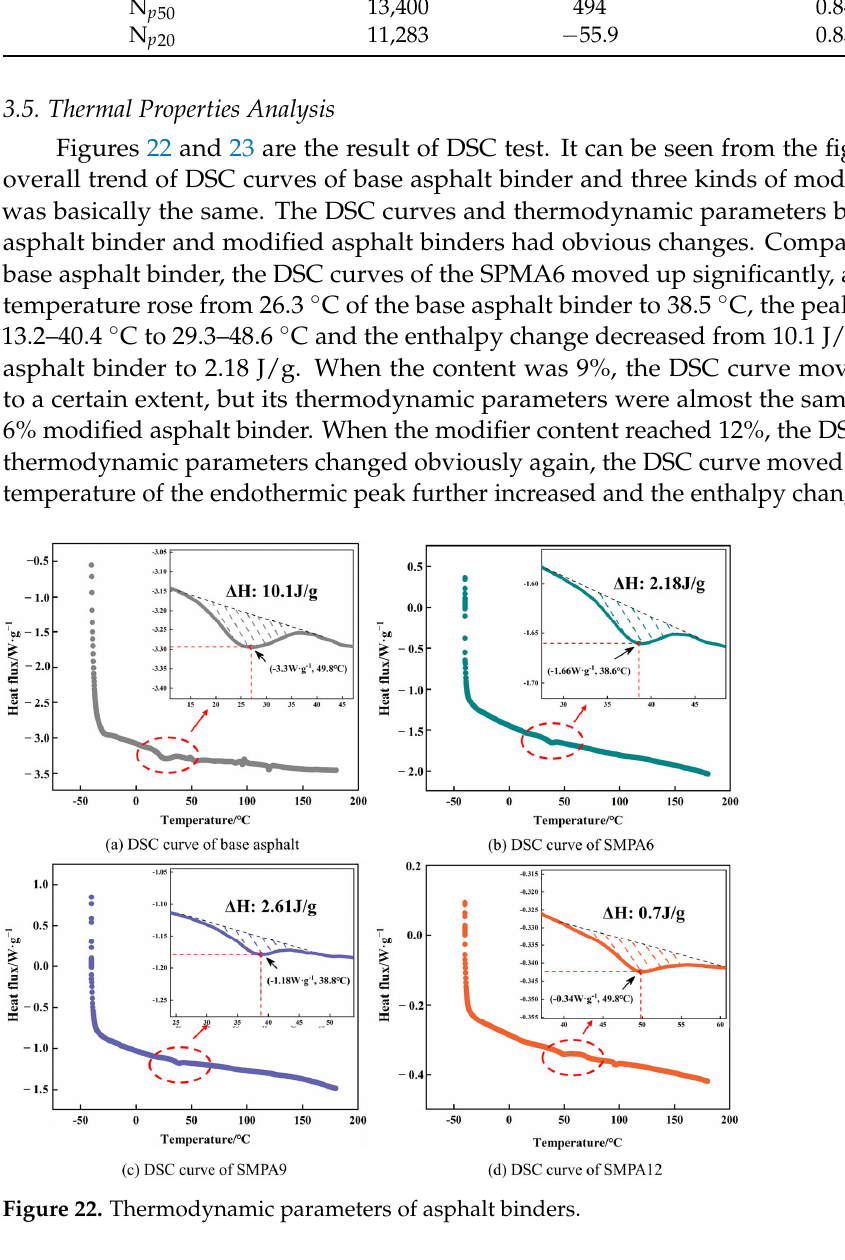
Figure 23. DSC curve of asphalt binders. 4. Conclusions The purpose of this study was to evaluate the effect of SPUA as the modifier on as ‐ phalt binders. First, the optimum process parameters of the modified asphalt binder were determined based on the orthogonal test. On this basis, by changing the amount of mod ‐ ifier in the asphalt binder, the high ‐ temperature and fatigue properties of the asphalt binder were tested and the applicability of each index to the modified asphalt binder was analyzed. According to the limited experimental results obtained in this study, the follow ‐ ing conclusions can be drawn: (1) Combined with extreme difference analysis and ANOVA, the best preparation pro ‐ cess parameters of modified asphalt binder under the condition of 9% content were